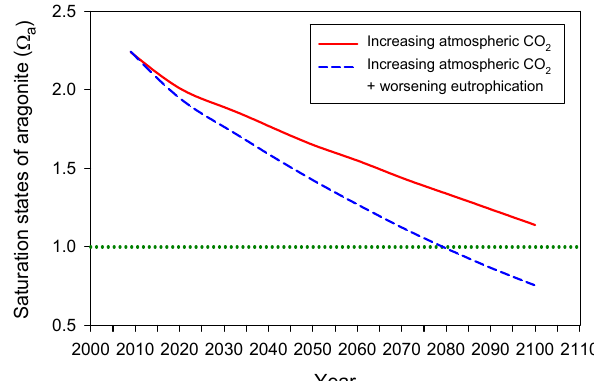
Fig. 12. The predicted time course of (cid:127) a changes in the bottom water of the Changjiang plume area within the 21st century due to (i) atmospheric CO 2 increase (IPCC IS92a scenario; solid line), and (ii) the combined effect of atmospheric CO 2 increase and worsening eutrophication (dashed